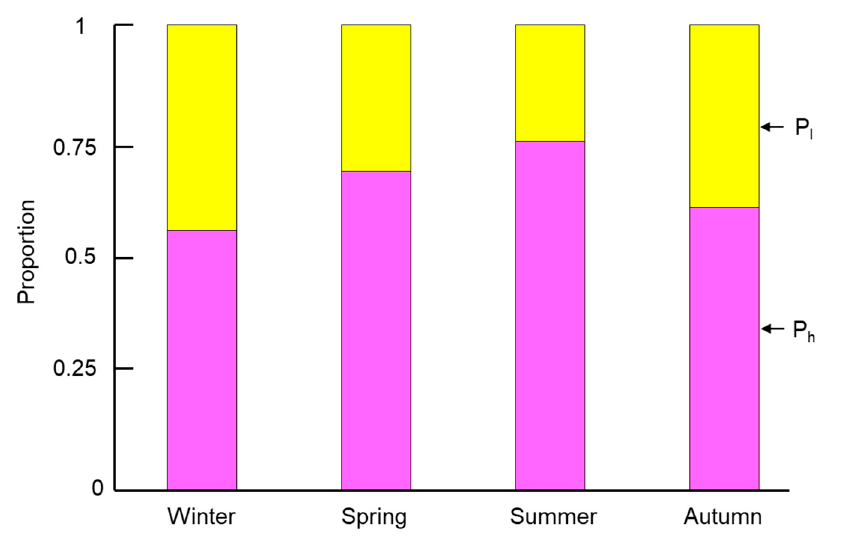
Figure 3. Fractions of P h and P l in atmospheric P c in Sapporo over the four seasons. Symbols: P h , emitted from the high-temperature combustion source (vehicles);, P l , emitted from low-temperature combustion sources (coal and biomass combustion).